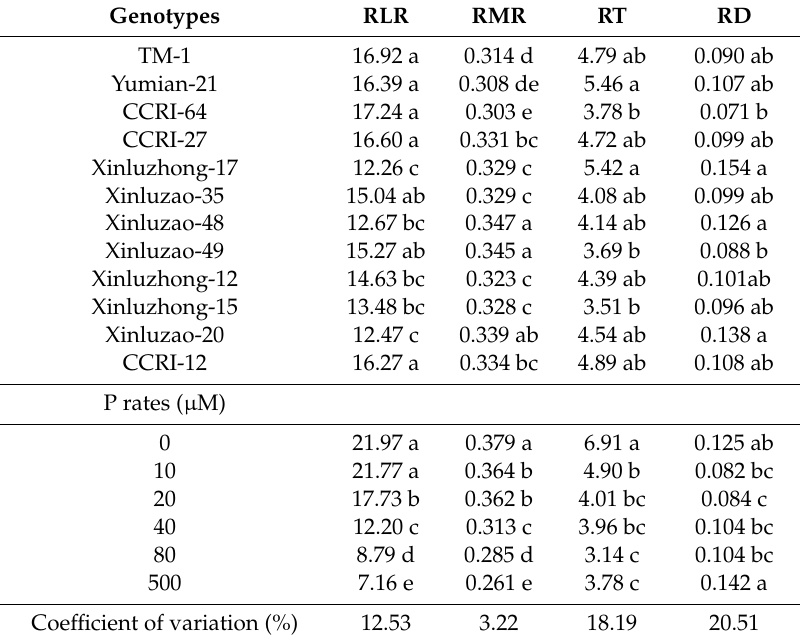
Table 3. Root length ratio (RLR), root mass ratio (RMR), root thickness (RT), and root density (RD) of 12 cotton genotypes grown at di ff erent P concentrations in hydroponic